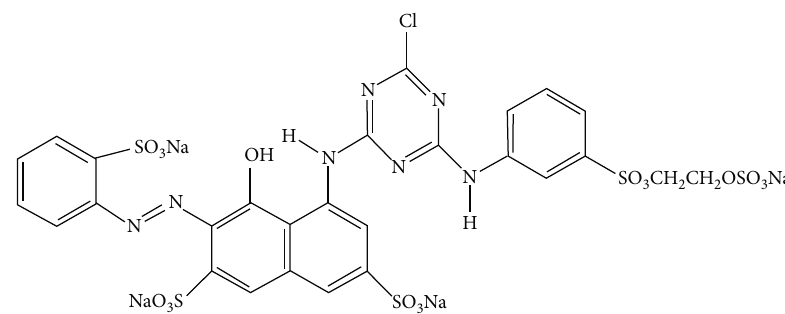
Figure 1: Structure of reactive Red